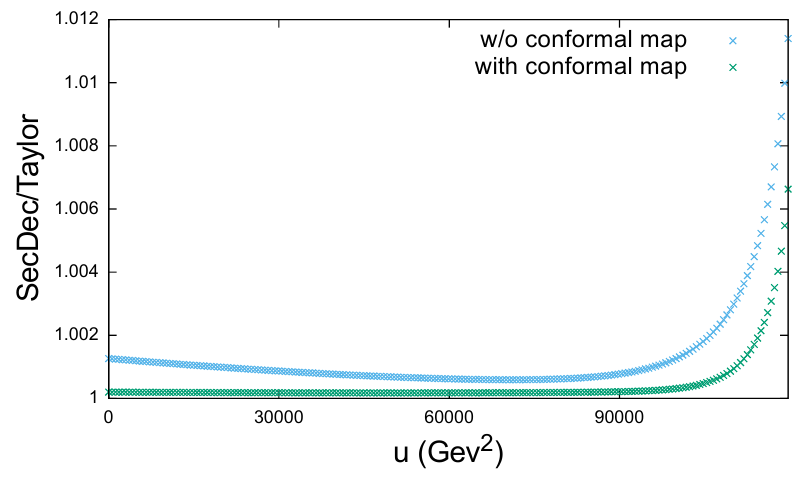
Figure 5 . The ratio of the SecDec result and an ordinary Taylor expansion (sixth-order) are shown with (green) and without (blue) conformal mapping, for the O ( (cid:15) 0 ) coe(cid:14)cent of the integral